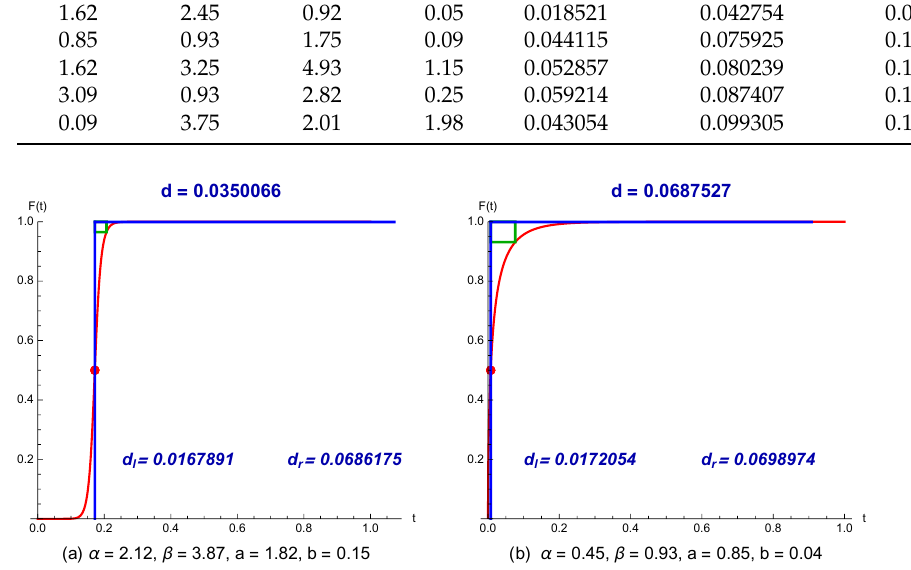
Figure 3. Approximation of CDF function of GOPC-W